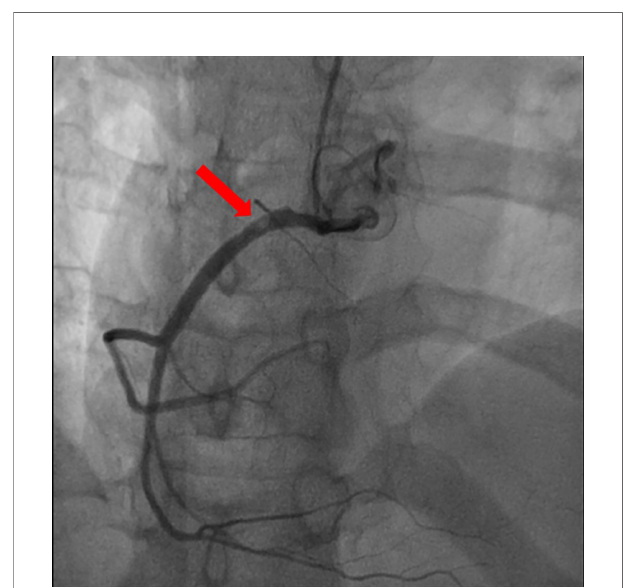
FIGURE 2 | Coronary angiography: non-obstructive free- fl oating intracoronary thrombus of the right coronary artery (red